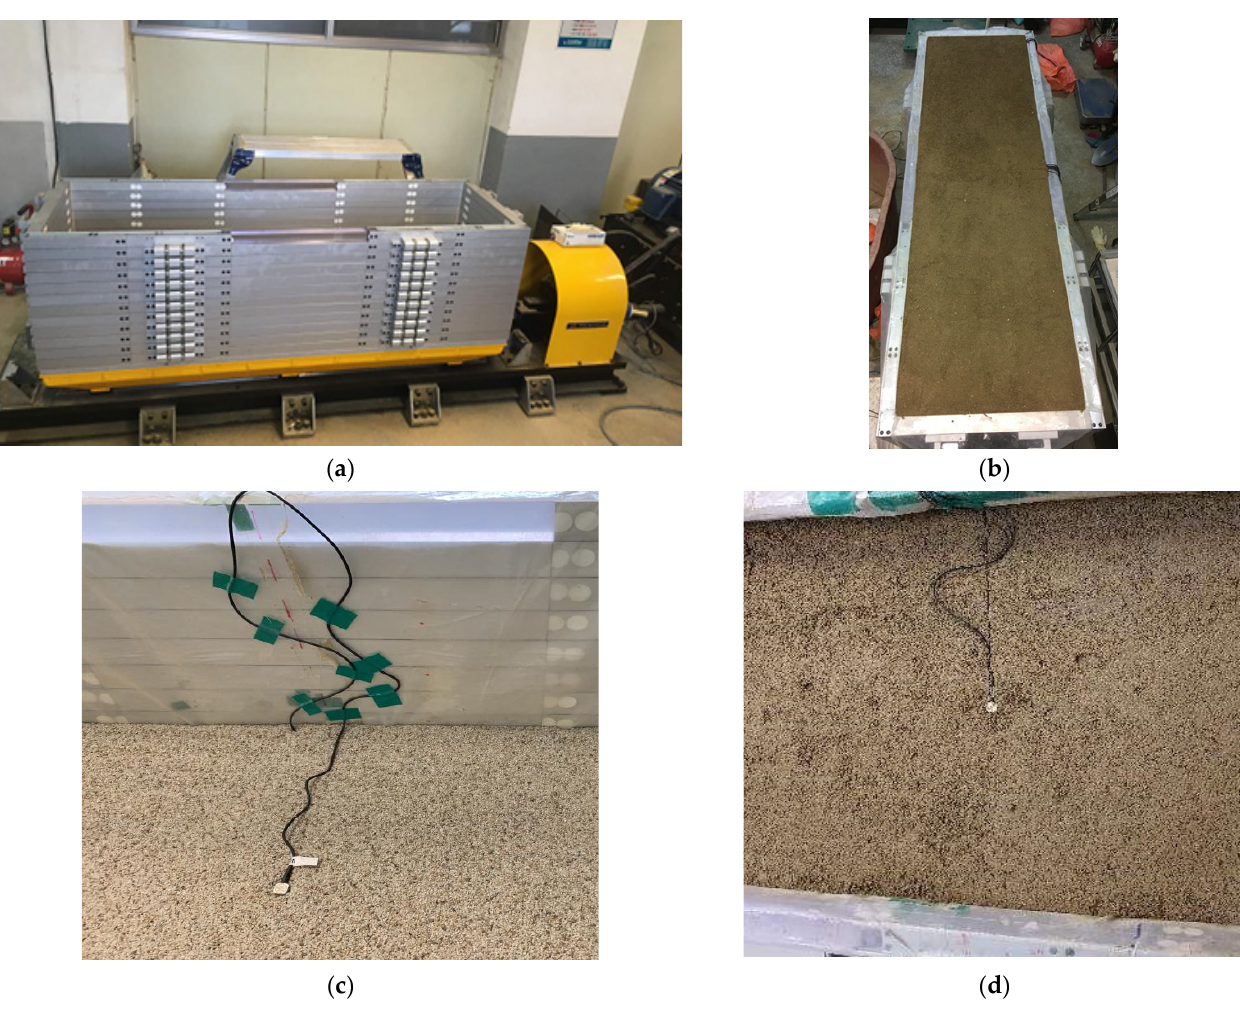
Figure 2. Laminar shear box: ( a ) Empty Laminar shear box in this study; ( b ) Soil sample set up in the LSB; ( c ) Accelerometer set up for a dense layer; ( d ) Accelerometer set up for a loose layer.